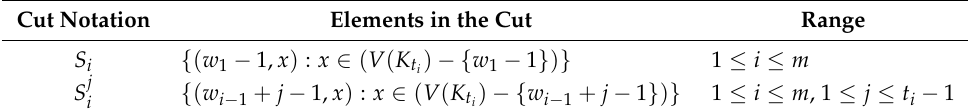
Figure 1. The edge cuts of windmill WM ( K 4 , K 5 , K 9 , K 17 ) . Table 1. Edge cuts in windmill